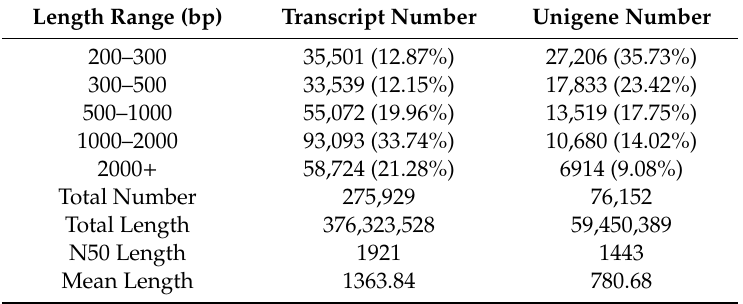
Table 2. Statistics of the unigene assembly results.